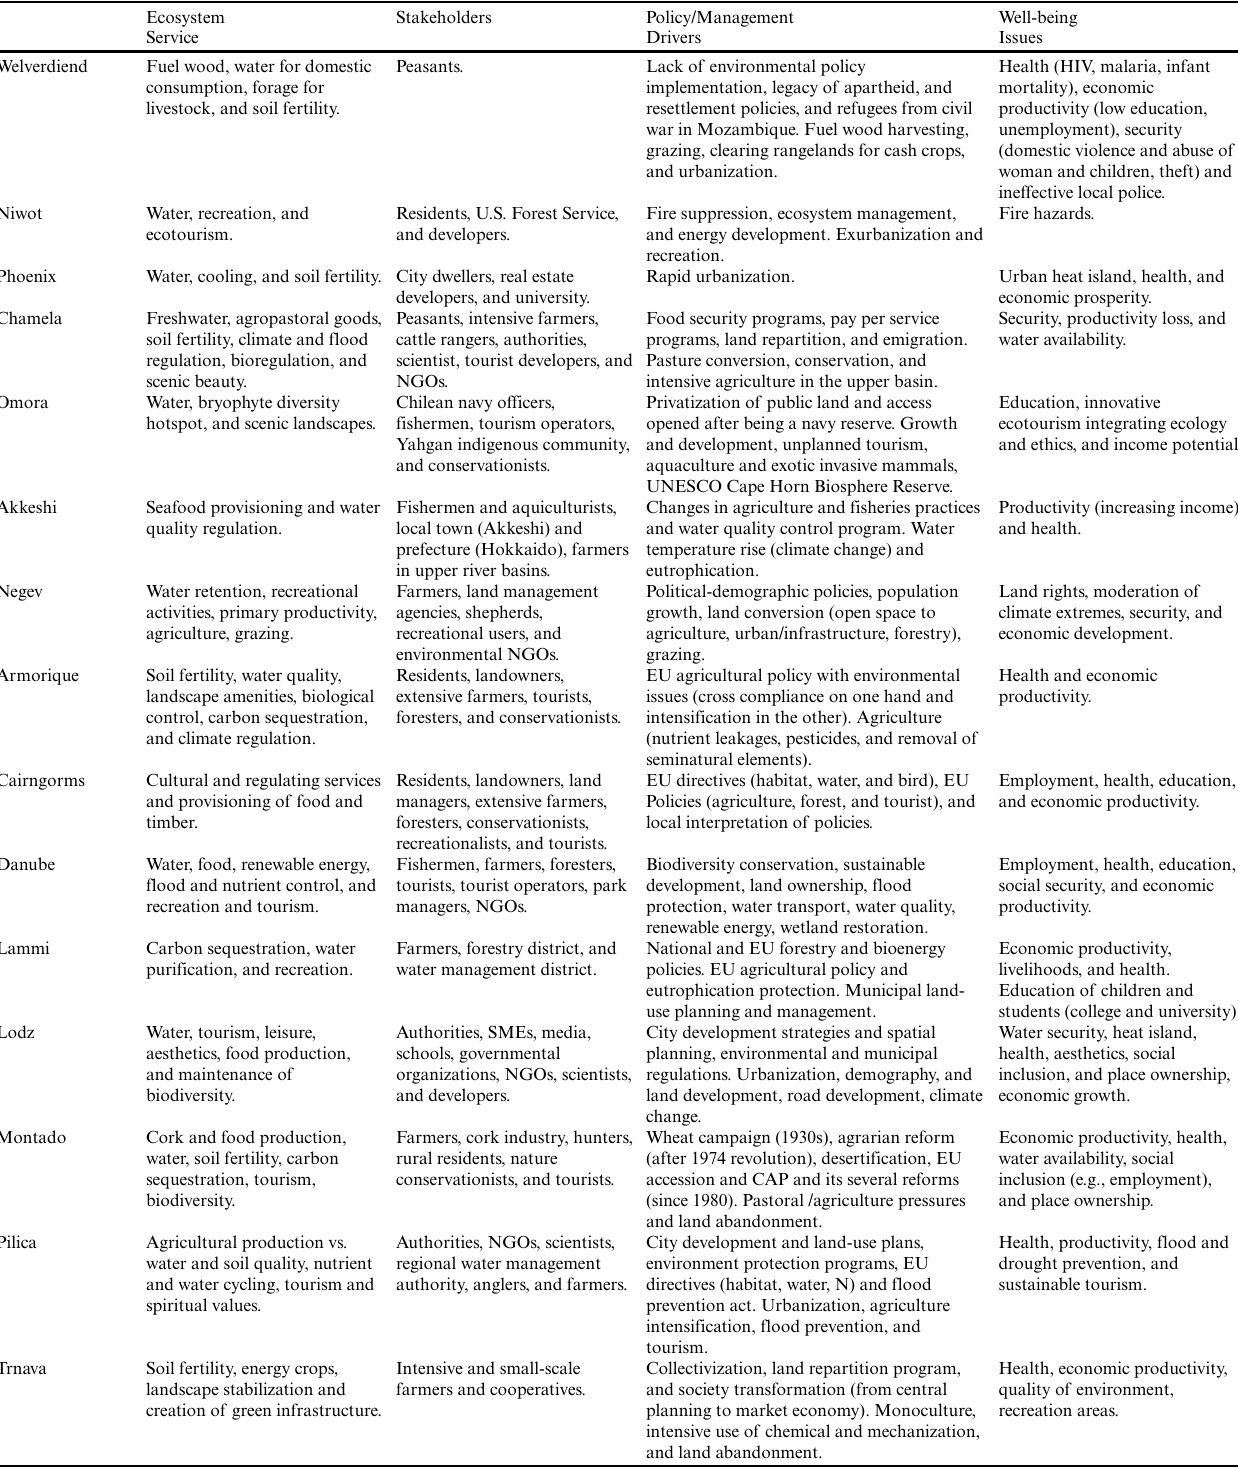
Table 2 . Ecosystem services and socioeconomic characteristics of the International Long-Term Ecological Research network (ILTER) potential participant sites in an ILTER/Programme on Ecosystem Change and Society (PECS) collaboration project (for other sites’ characteristics, please refer to Table 1 and Figures 3 and